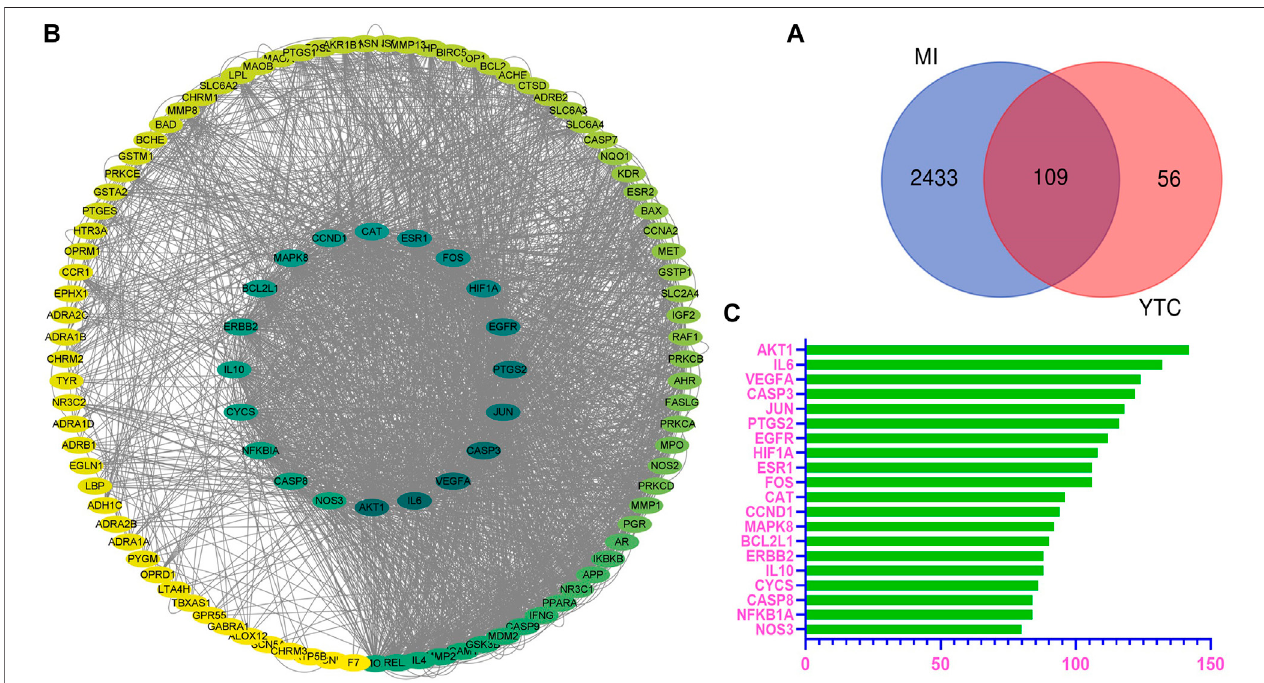
FIGURE 1 | Overlapped targets screen. (A) The protein-protein interaction (PPI) network of targets. The colors of the nodes are illustrated from green to yellow in descending order of degree values. (B) Overlap targets of YTC and MI. The blue circles represent MI targets and the red circles represent YTC targets. The overlapped area is the targets of YTC anti-MI. (C) The top 20 genes in the PPI network were selected based on the degree.